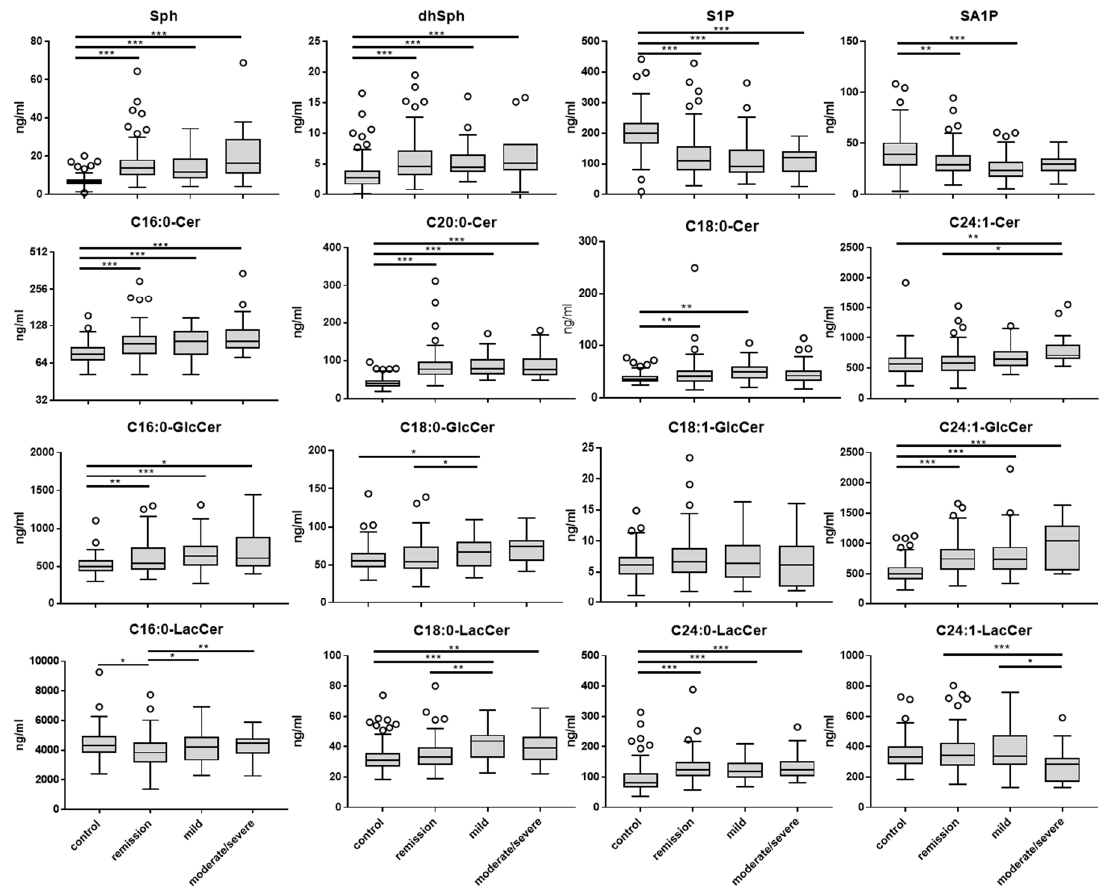
Figure 4. Sphingolipids in human plasma. Sphingolipids in human plasma was determined by